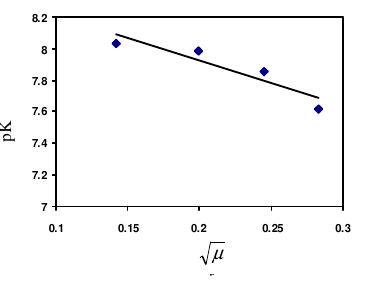
Figure 1. Plot of pK vs. µ Figure 2. Plot of log K